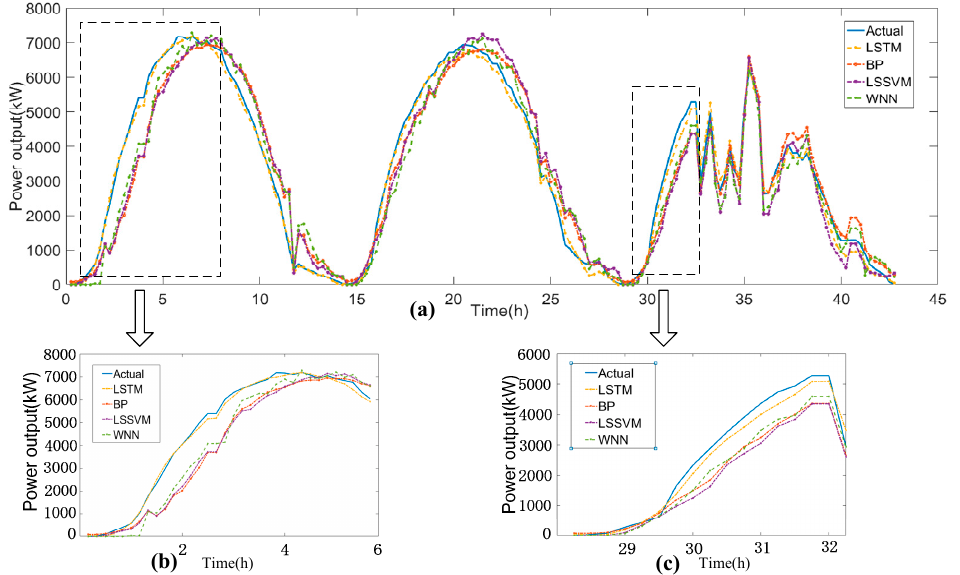
Figure 10. Short-term PV power forecasting in spring by various algorithms. ( a ): the general forecasting power trend of three days ( b ): the trend in the first 5 hours in (a) ( c ): the trend from 28th to 32th hour in (a).